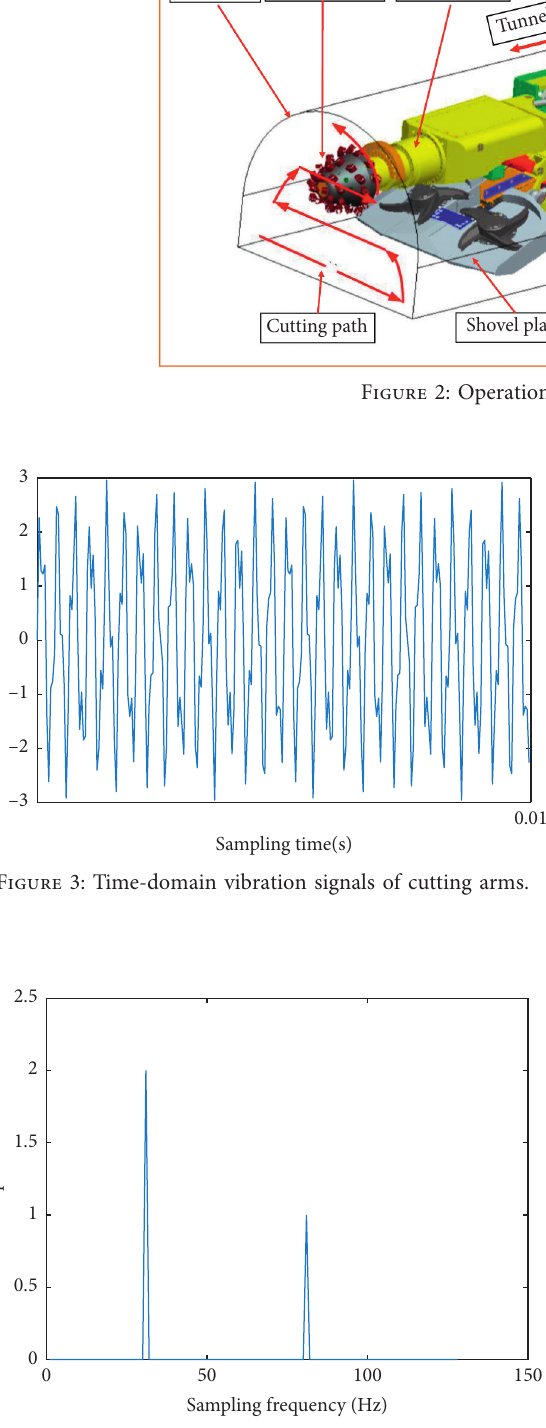
Figure 4: Frequency-domain vibration signals of cutting